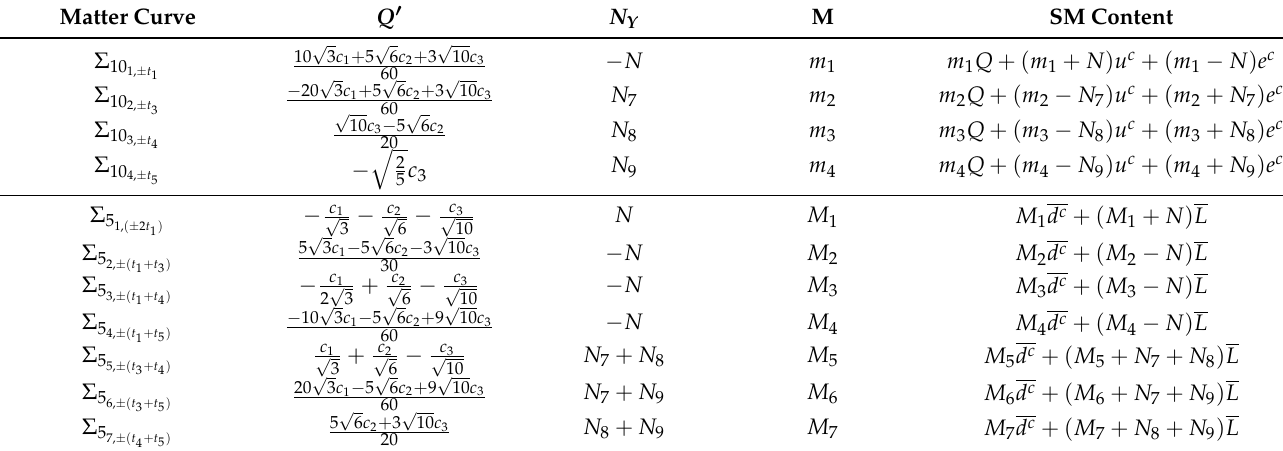
Table 1. Matter curves along with their U ( 1 ) (cid:48) charges, flux data and the corresponding SM content. Note that the flux integers satisfy N = N 7 + N 8 + N 9 . Matter